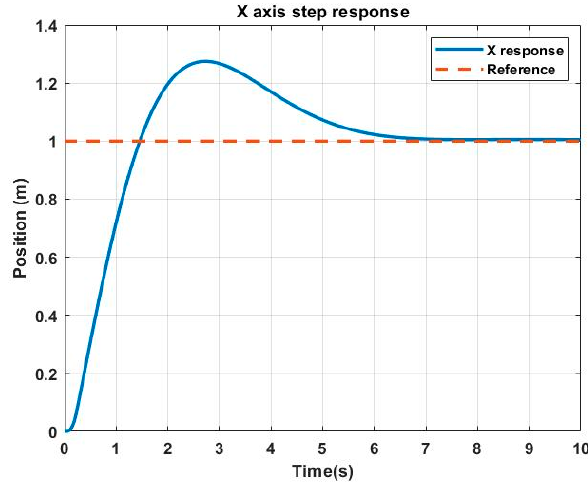
Figure 21. PID step response in X axis.